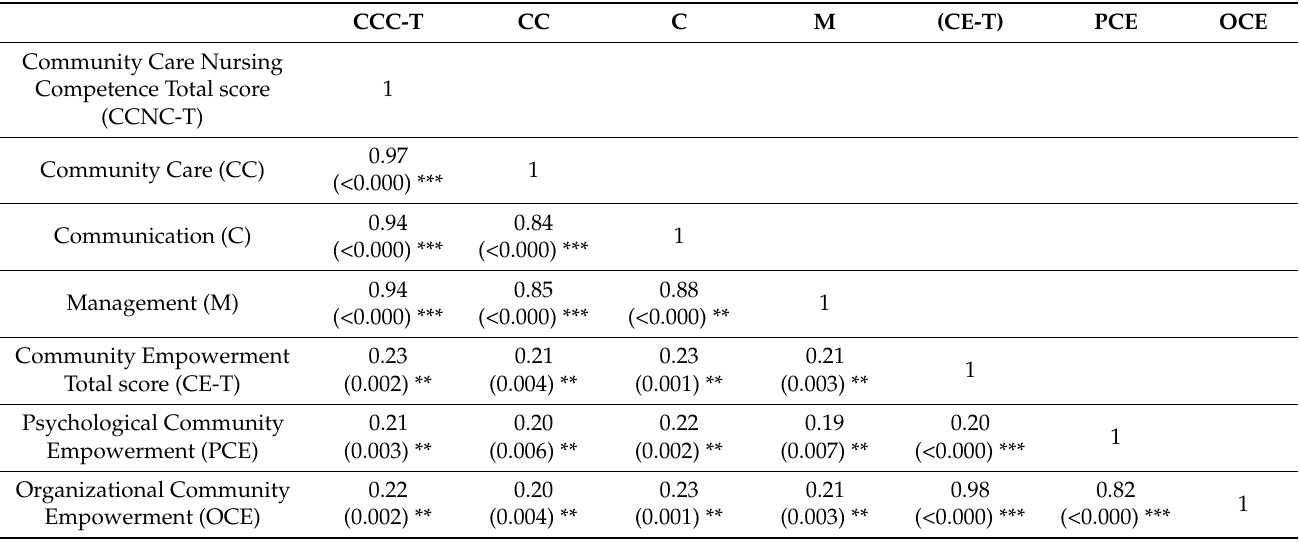
Table 2. Correlation between community care nursing competence and community empowerment ( n = 197).